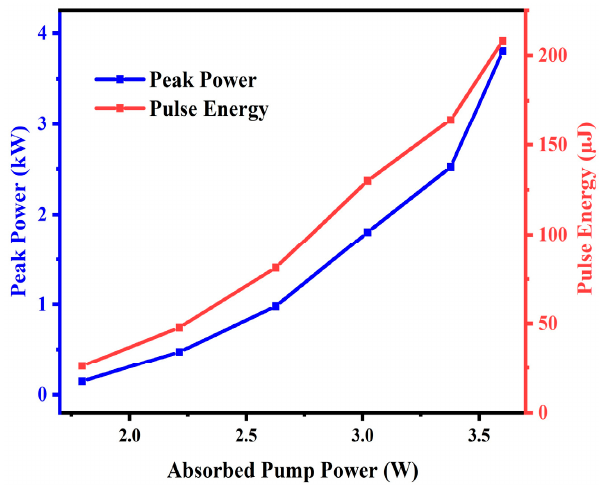
Figure 6. The dependences of pulse energy and pulse peak power on the absorbed pump power at T = 3%.